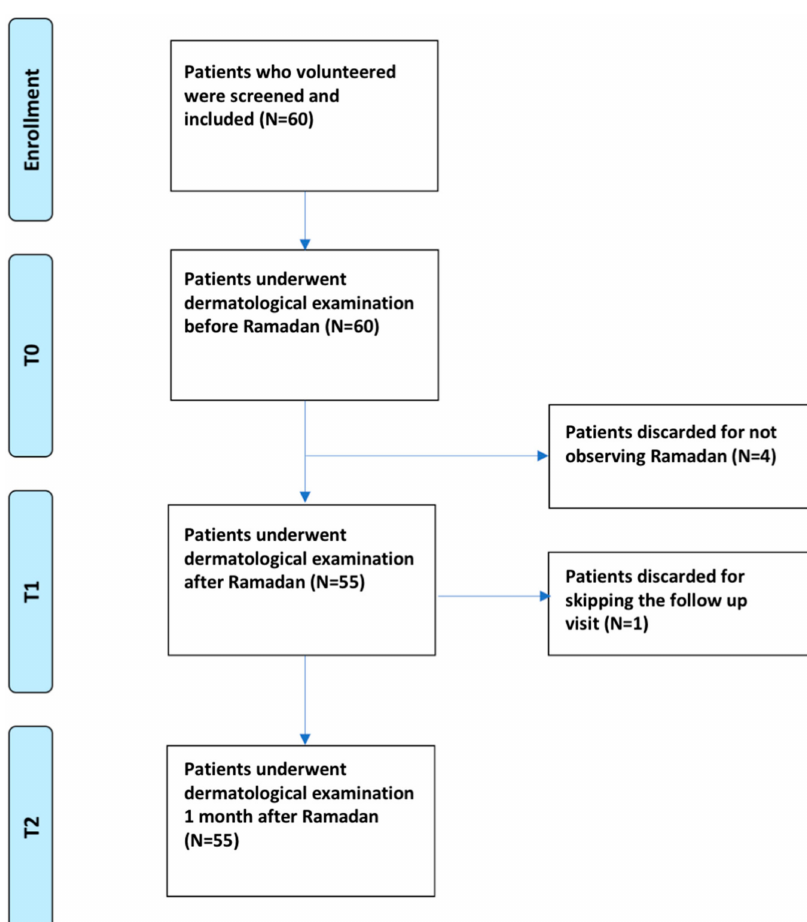
Figure 1. The study flow diagram, showing the di ff erent steps and time-points of the investigation (T 0 before the beginning of the month of Ramadan, T 1 after the end of the Ramadan fasting, and T 2 one month after the fasting